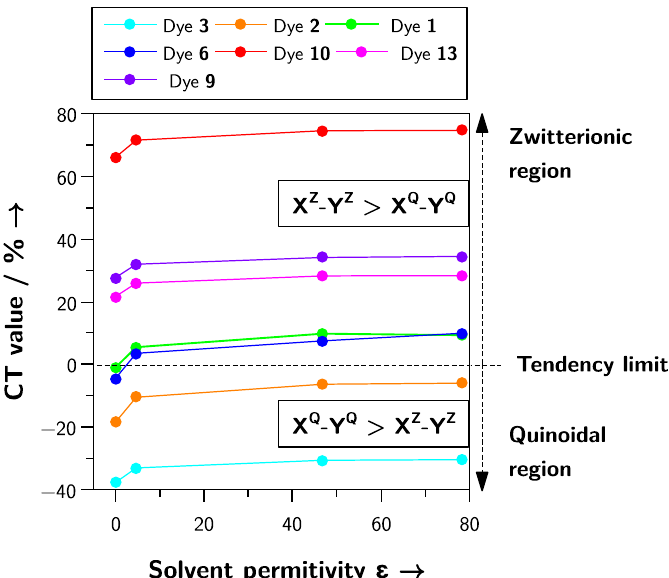
Figure 5. Difference in the percentage participation of the phenolate moiety between the zwitteri- onic and quinoidal mesomeric structures of dyes 1 – 13